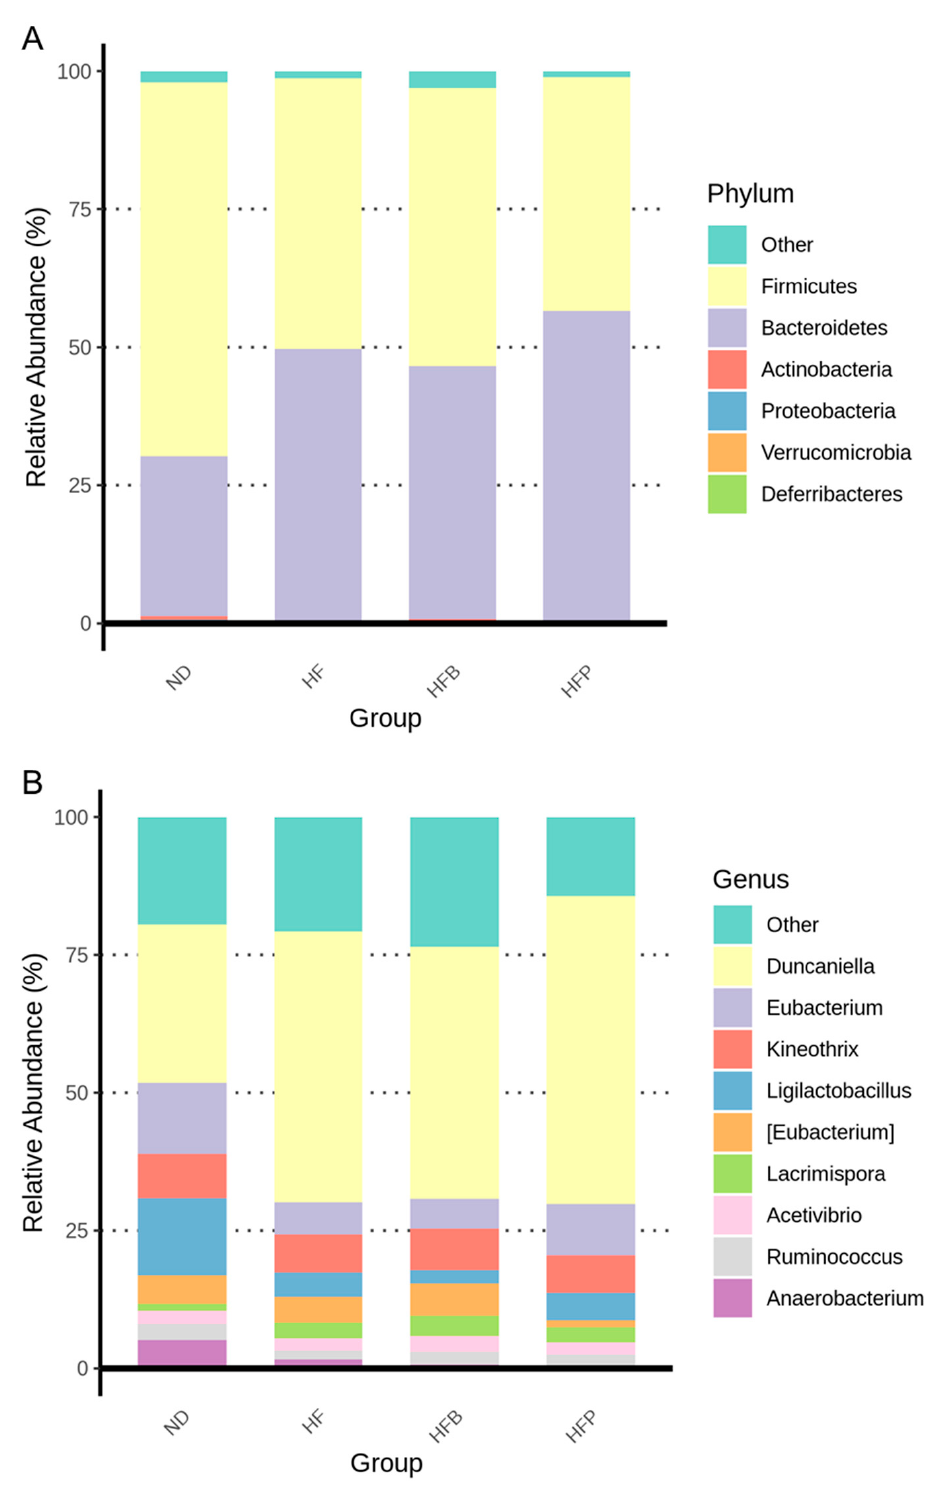
Figure 5. Relative abundance of dominant ( A ) phyla and ( B ) genera in the gut microbiota of male offspring at 12 weeks of age.